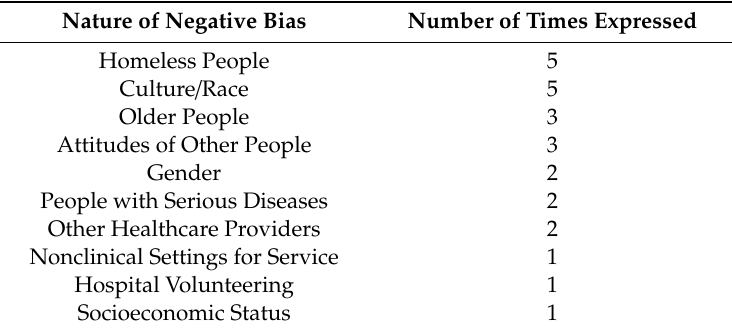
Table 3. Summary of biases expressed by students (Item 11 of Table 1) in the survey about their team service-learning experiences (19 of 26 students stated one or more of their